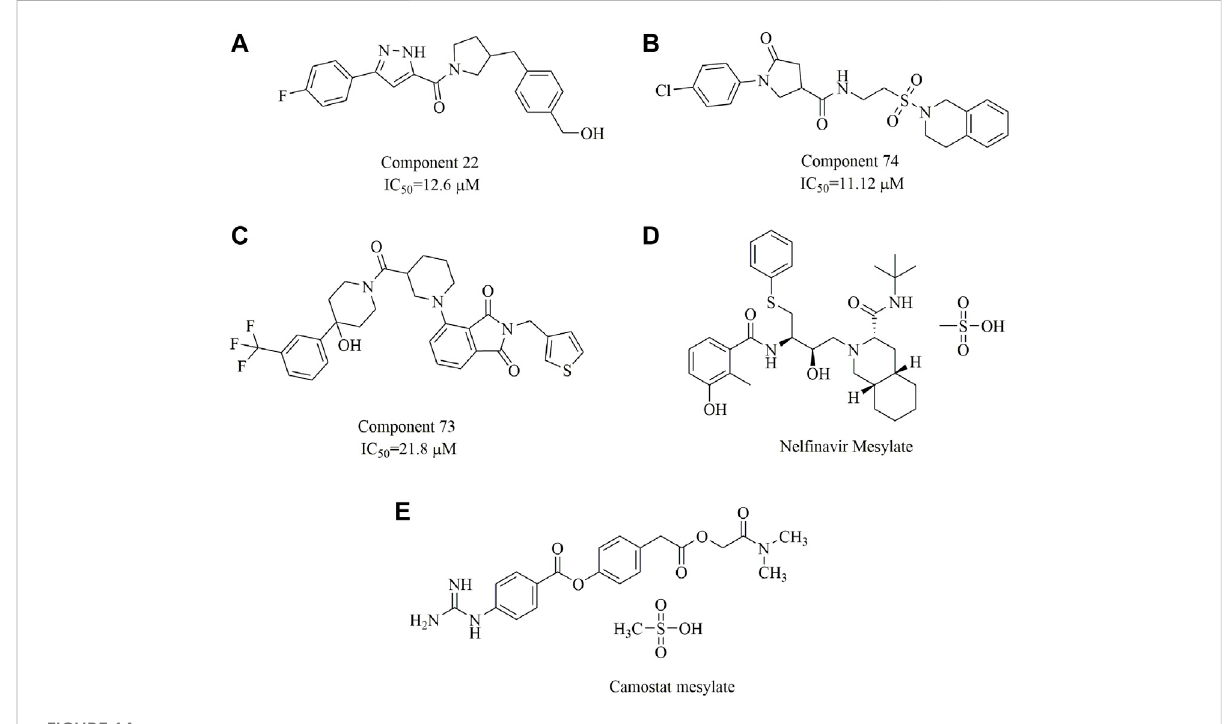
FIGURE 14 Chemical structures of the identi fi ed small-molecule fusion inhibitors against MERS-CoV and their inhibitory